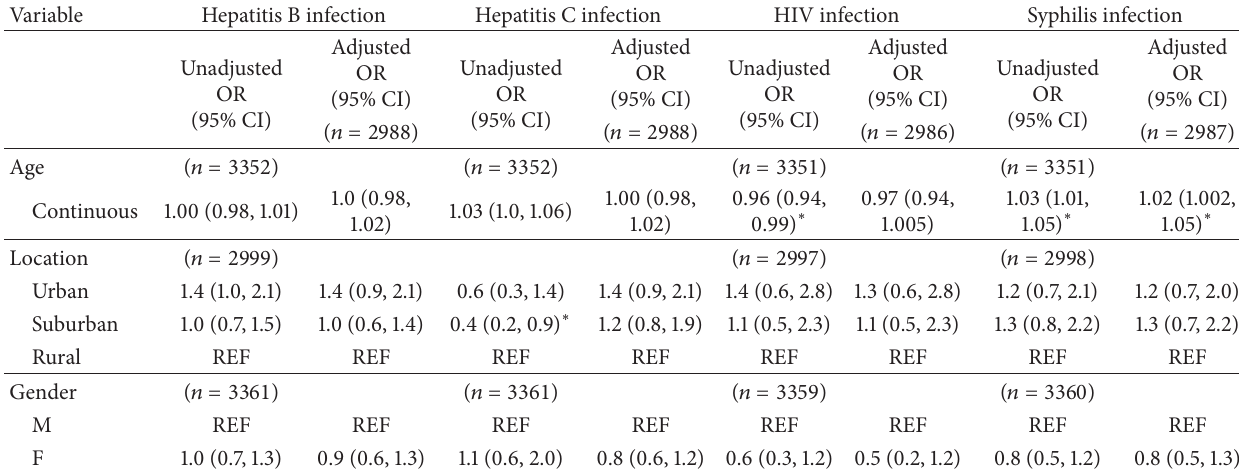
Table 4: Predictors of hepatitis B, C, HIV, and syphilis in blood